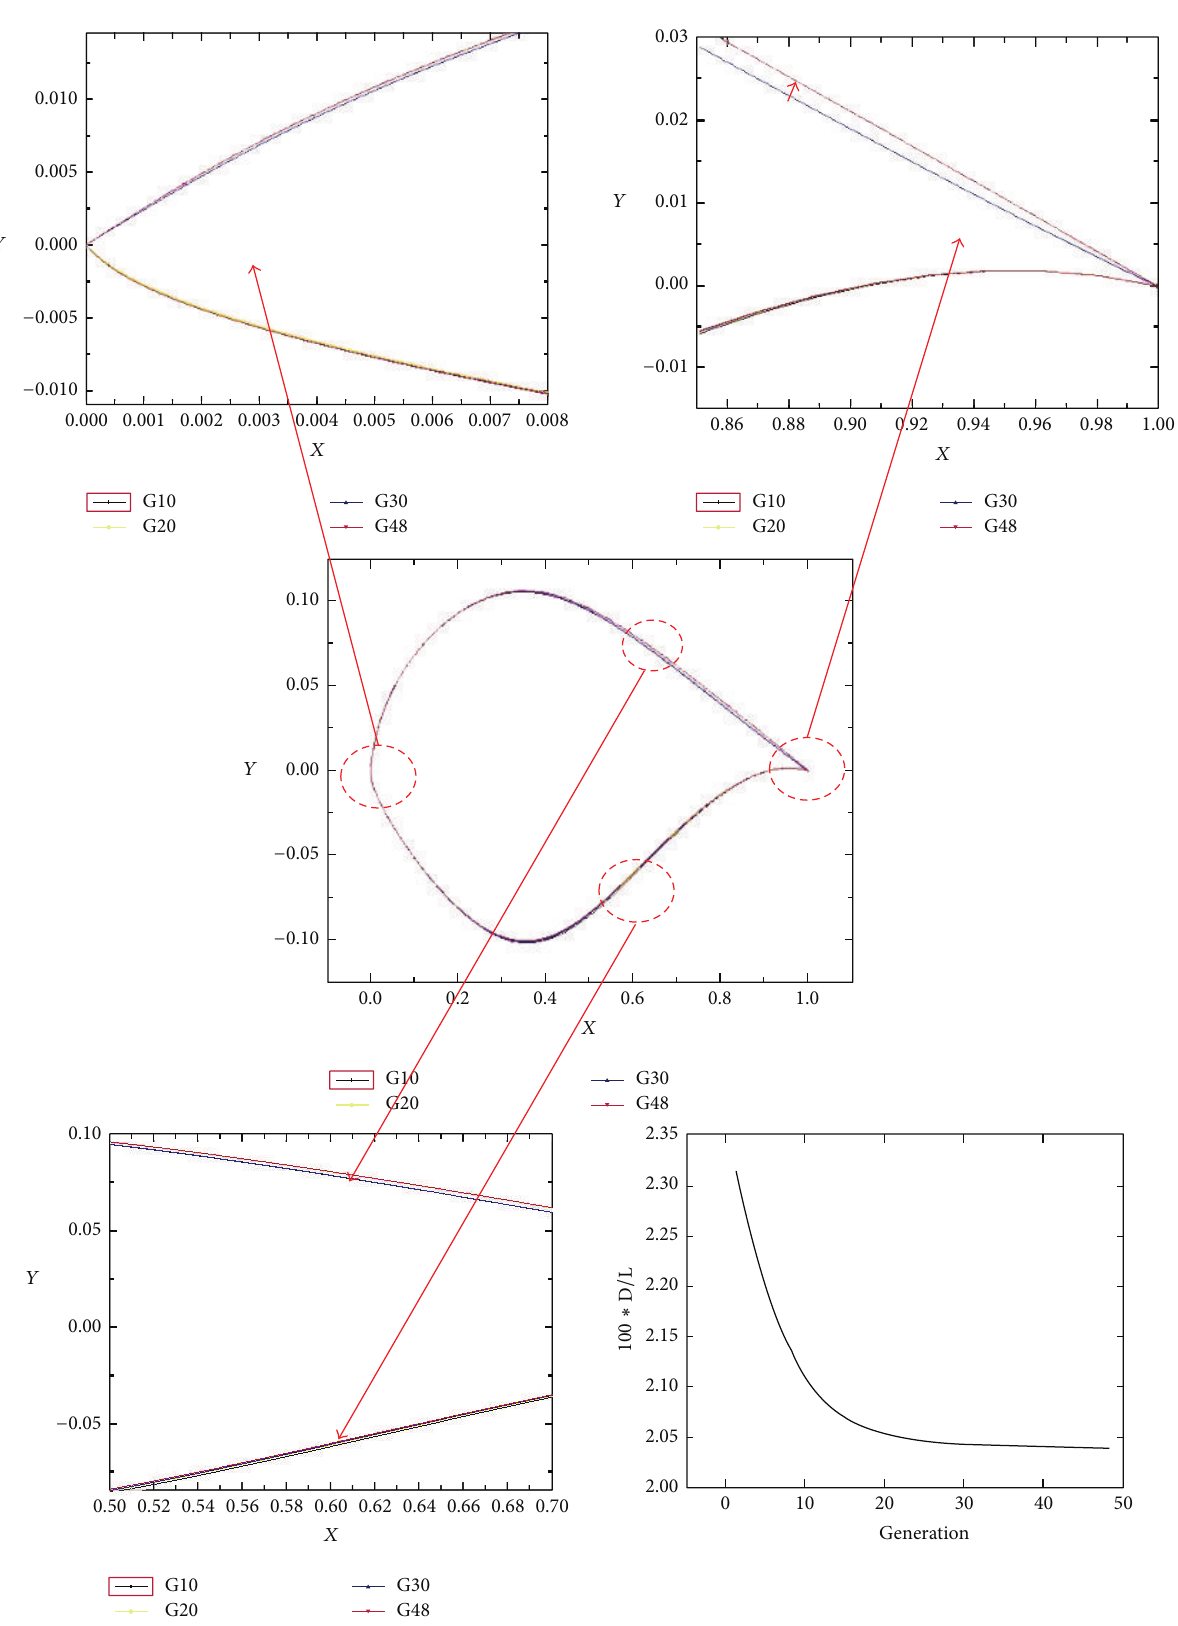
Figure 8: Shape evolution of airfoil and variation in drag to lift ratio at 58% span location in various generations of